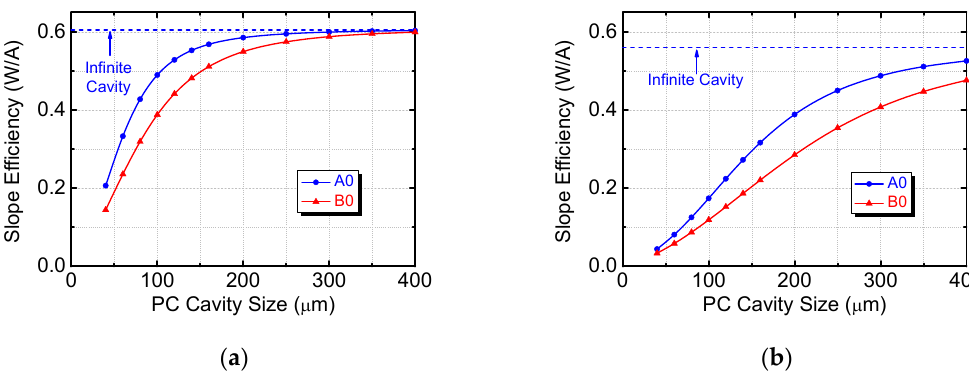
Figure 8. Finite cavity with RIT design ( f = 0.25): the slope efficiency of the two lowest threshold fundamental modes as a function of PC cavity size for ( a ) air-hole and ( b ) air-pillar PC-SELs.